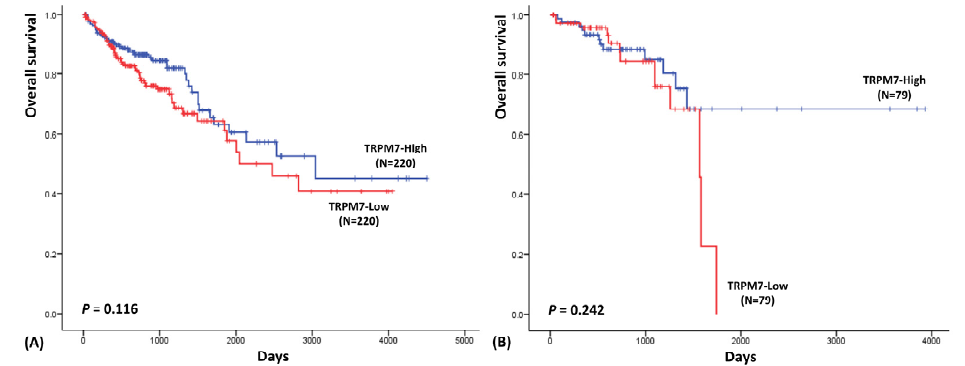
Figure 1. Overall survival analysis of TRPM7 in colon cancer ( A ) and rectal cancer ( B ).